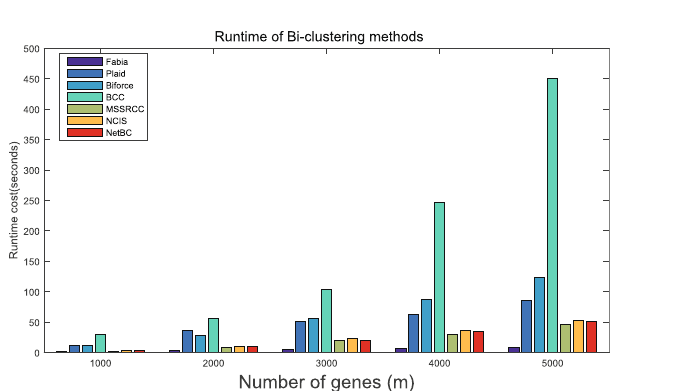
Figure 10. Runtime costs of eight bi-clustering methods under different number of genes, the number of samples is fixed as